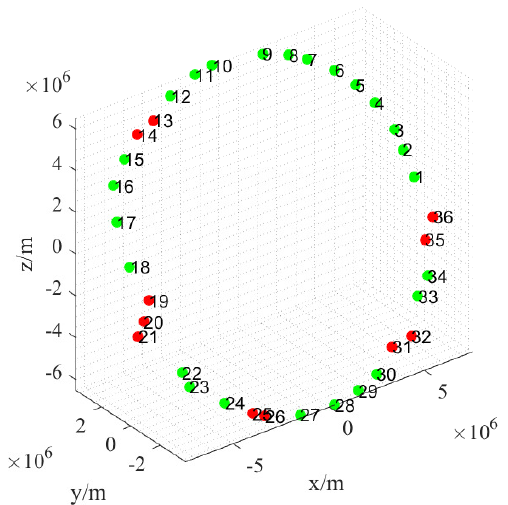
Figure 11. The initial distribution of the coplanar satellites in the geocentric inertial system. Red dots represent satellites that do not satisfy the continuous coverage constraint while green dots represent satellites that satisfy the continuous coverage constraint.